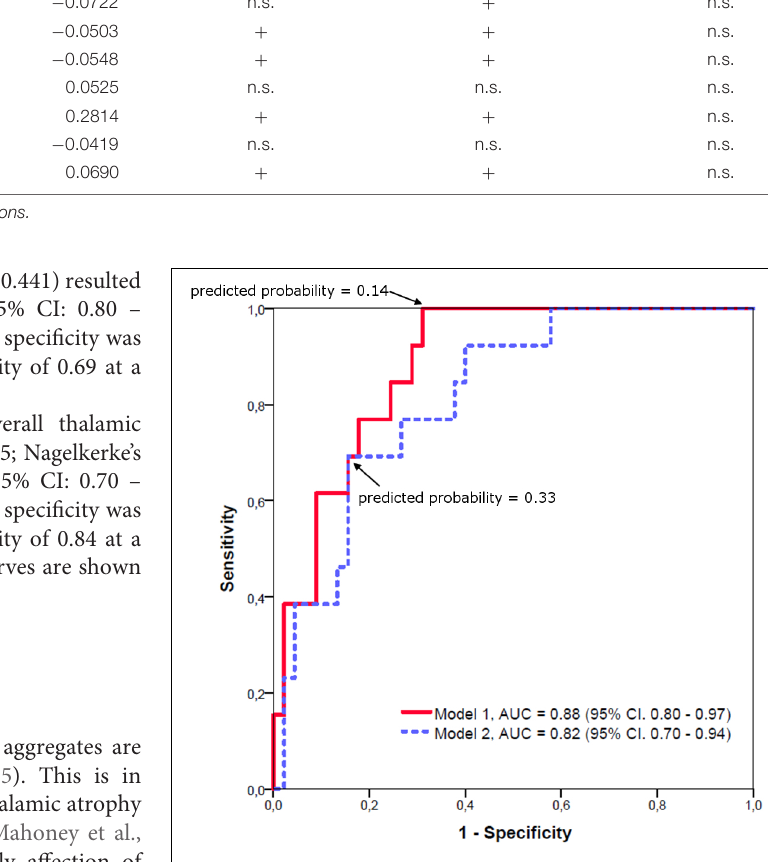
FIGURE 4 | Receiver operating characteristic curves for logistic regression models of C9orf72 mutation carriers versus sporadic patients. Model 1: Using the prefrontal subregion of the thalamus and the LI of the occipital subregion of the thalamus as predictor variables results in an AUC of 0.88. Model 2: Using only overall thalamic volume as predictor variable still results in an AUC of